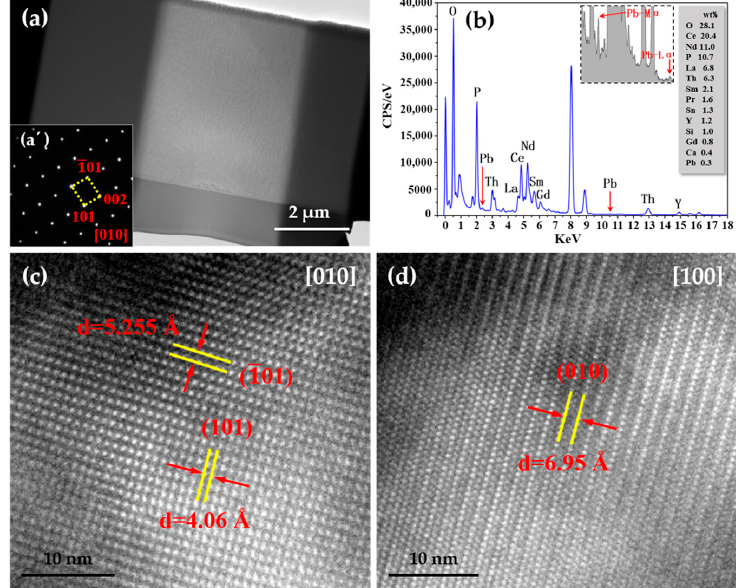
Figure 4. ( a ) The TEM bright-field (BF) image and selected area electron diffraction (SAED) (( a´ ) viewed along the [010] direction) of the monazite grain. ( b ) The EDS spectrum of the monazite grain in ( a ). The inset in Figure 4b is enlarged EDS spectrum with red arrows point to the peaks of Pb-M α and Pb-L α . ( c , d ) The high-resolution transmission electron microscopy (HRTEM) images of two monazite foils viewed along the [010] and [100] direction, respectively. The monazite we studied is well crystalline .